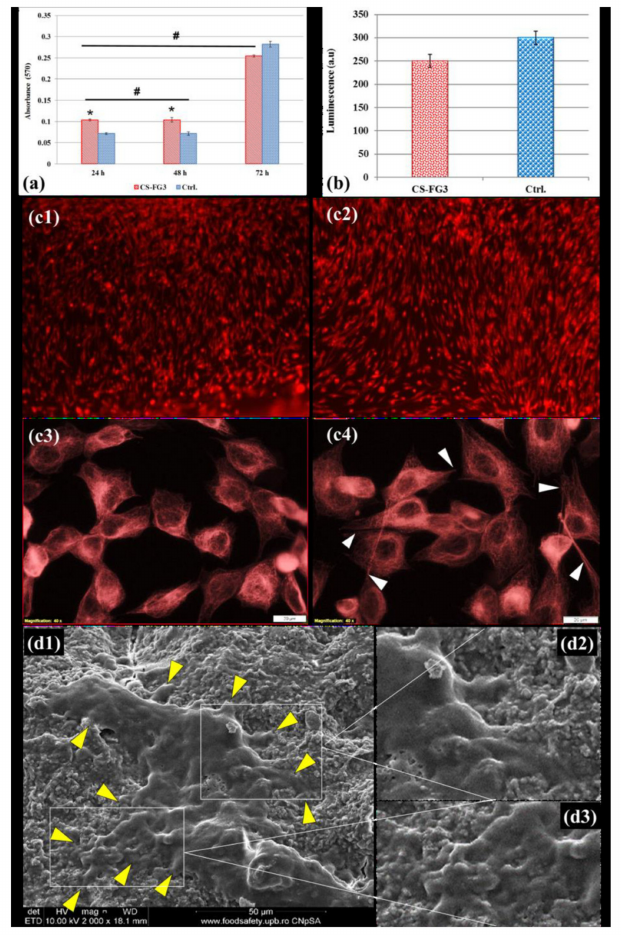
Figure 7. In vitro biocompatibility investigation: ( a ) cell viability results based on the MTT assay for the CS–FG3 sca ff old and Ctrl (control culture) (results are represented as the mean ± standard error, n = 3, p < 0.05); ( b ) oxidative stress analysis for the Ctrl and CS–FG3 sca ff old based on GSH-Glo assay (results are represented as the mean ± standard error, n = 3, p < 0.05); ( c ) fluorescence microscopy images at 72 h post-seeding, representative for cellular confluence ( c1 , c2 ) and for cellular morphological details ( c3 , c4 ): Ctrl ( c1 , c3 ), CS–FG3 sca ff old ( c2 , c4 ); ( d1 ) representative SEM micrograph of elongated well spread cells on the CS–FG3 sca ff old, at 72 h post-seeding; arrow heads indicate cell attachment through filopodia; ( d2 , d3 ) morpho-structural details showing cellular filopodia on the FG–CS3 composite sca ff